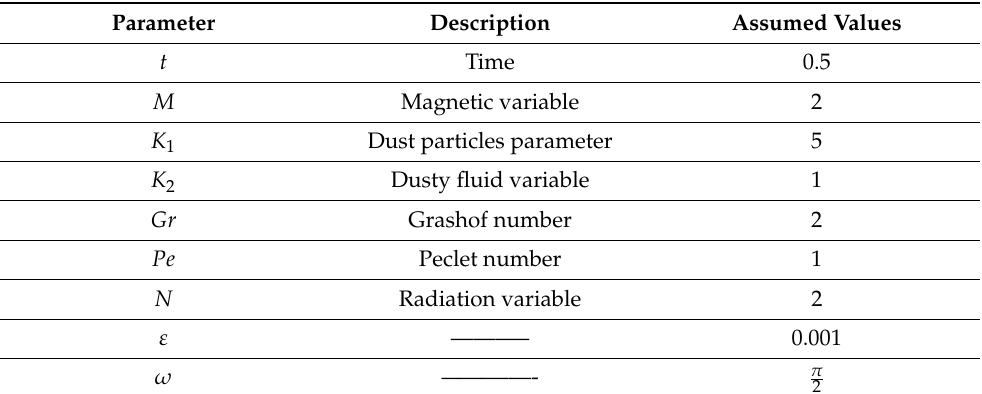
Table 1. Description of variables and parameters for graphical results